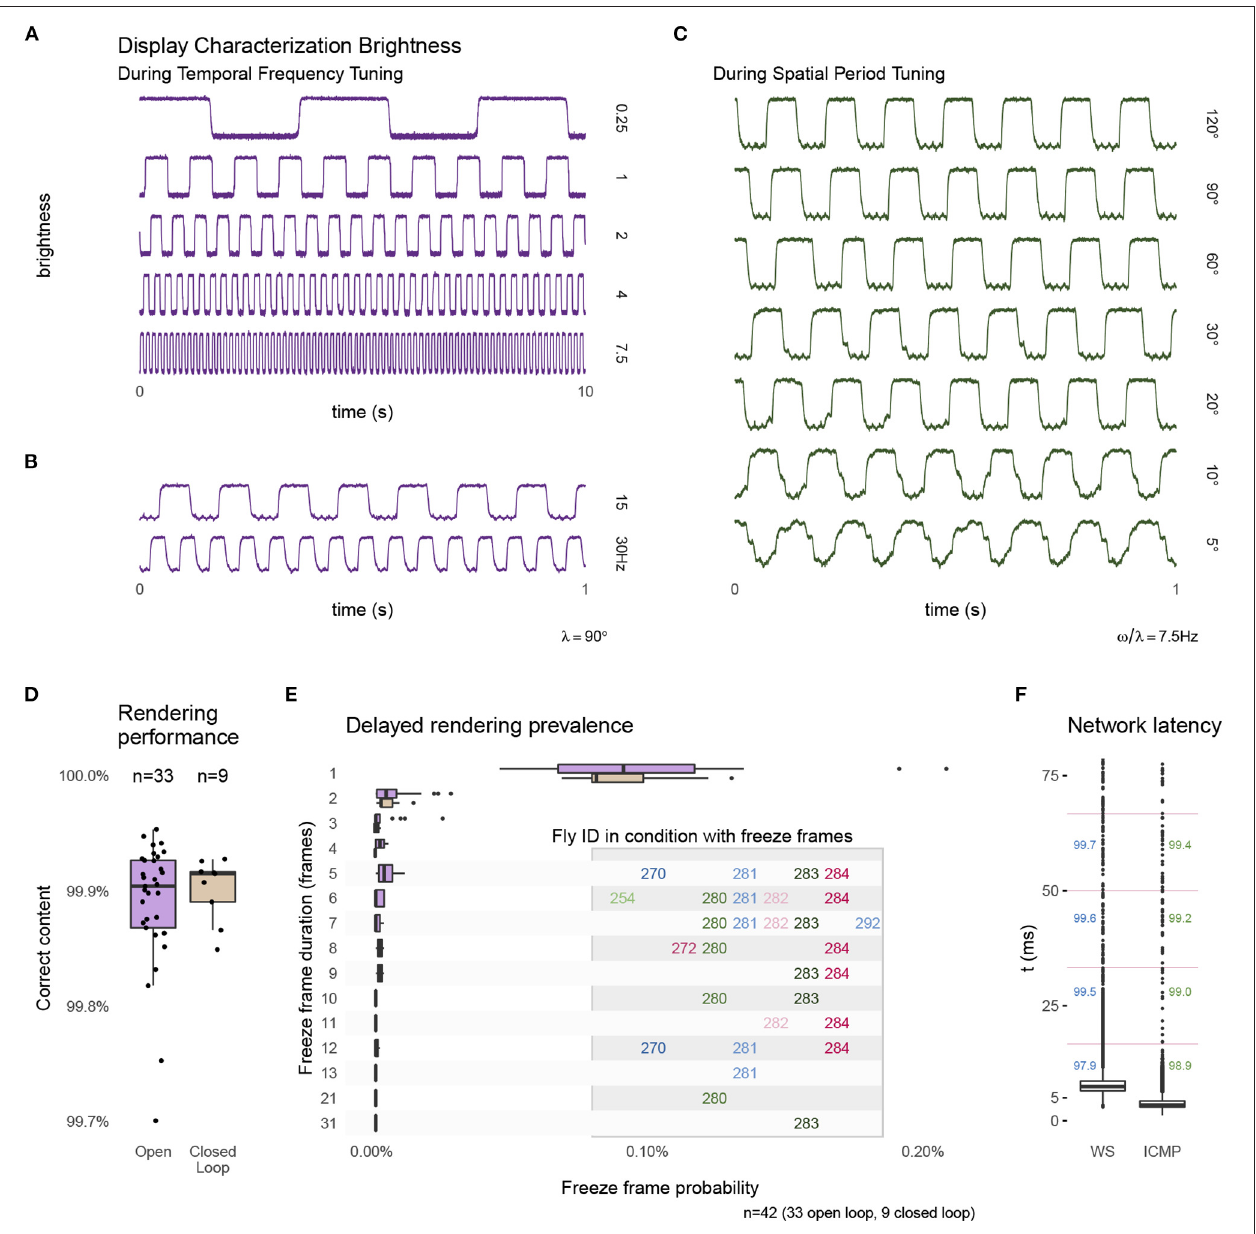
FIGURE 4 | Technical performance of the experimental setup. During the presentation of moving grating patterns we measured changes in display brightness at the approximate location marked in Figure 3B . The measurements show a regular pattern that changes at the expected temporal frequency (A,B) and at the same temporal frequency of 7.5Hz during conditions showing different spatial period grating motion (C) . The apparent filtering for the patterns with the finest bars is due to spatial averaging by the sensor. The traces show a small ripple of high frequency noise, this 60 Hz noise is in the sensor measurement and not due to the display. (D) The percentage of frames that were rendered correctly and within the expected time interval (see text for further details) during open-loop and closed-loop experiments. (E) Details of the frames that were not rendered within 1 frame interval shows a majority delayed by a single frame. A very small number of longer delays occurred, and all were from the same, few experiments. (F) The measured network latency for a round-trip message between FlyFlix server and client through WebSocket compared to a network ping (ICMP). The numbers mark the percentage of round-trips that would arrive within the 1st, 2nd, 3rd, or 4th ∼ 17ms display frame (indicated by the vertical lines). Box plots show the first and third quartile for the box, median for the center line, the whisker extend to 1.5 of the inter-quartile range (IQR). Panel (D) shows all data points, (E,F) only the outliers as individual points.